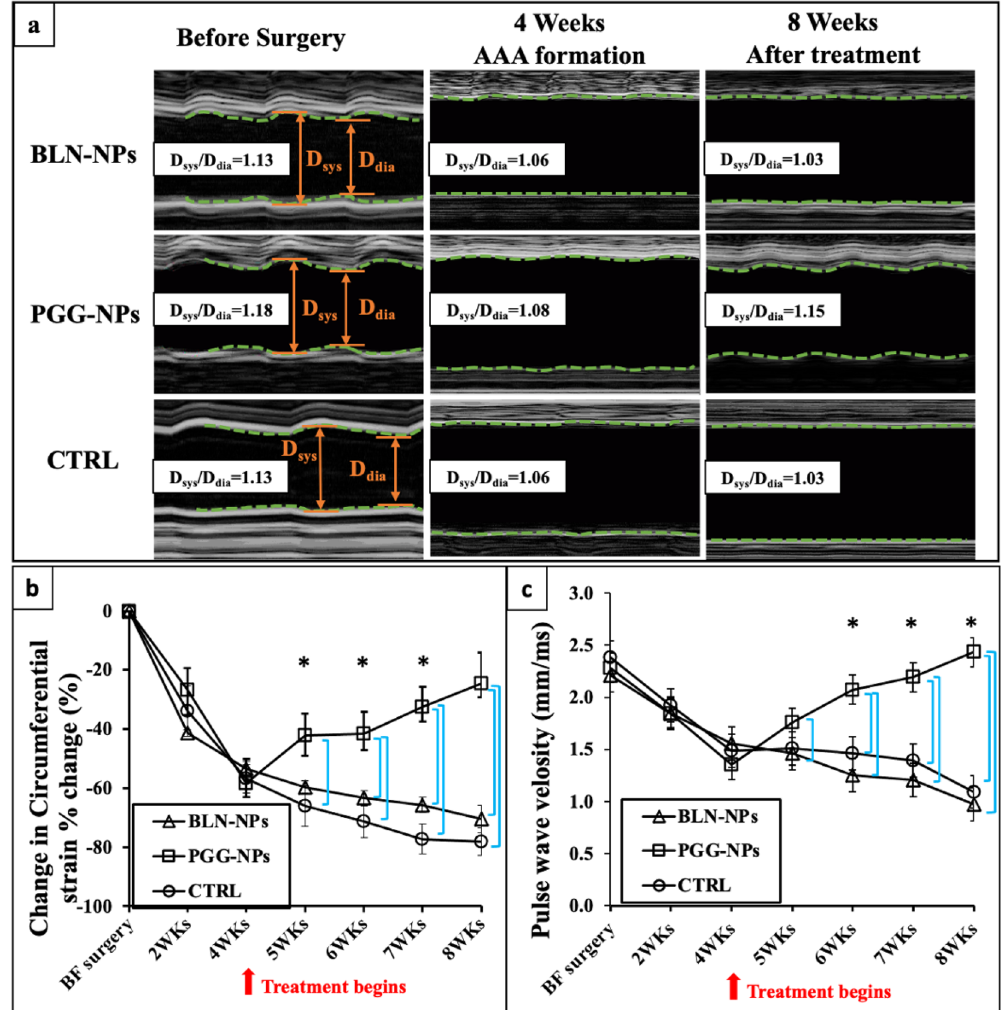
control group kept decreasing due to further aortic dilation. * indicate timepoint that have dilation percentage significantly different from week 4 (p < 0.05); bars indicate significant difference between groups (p <